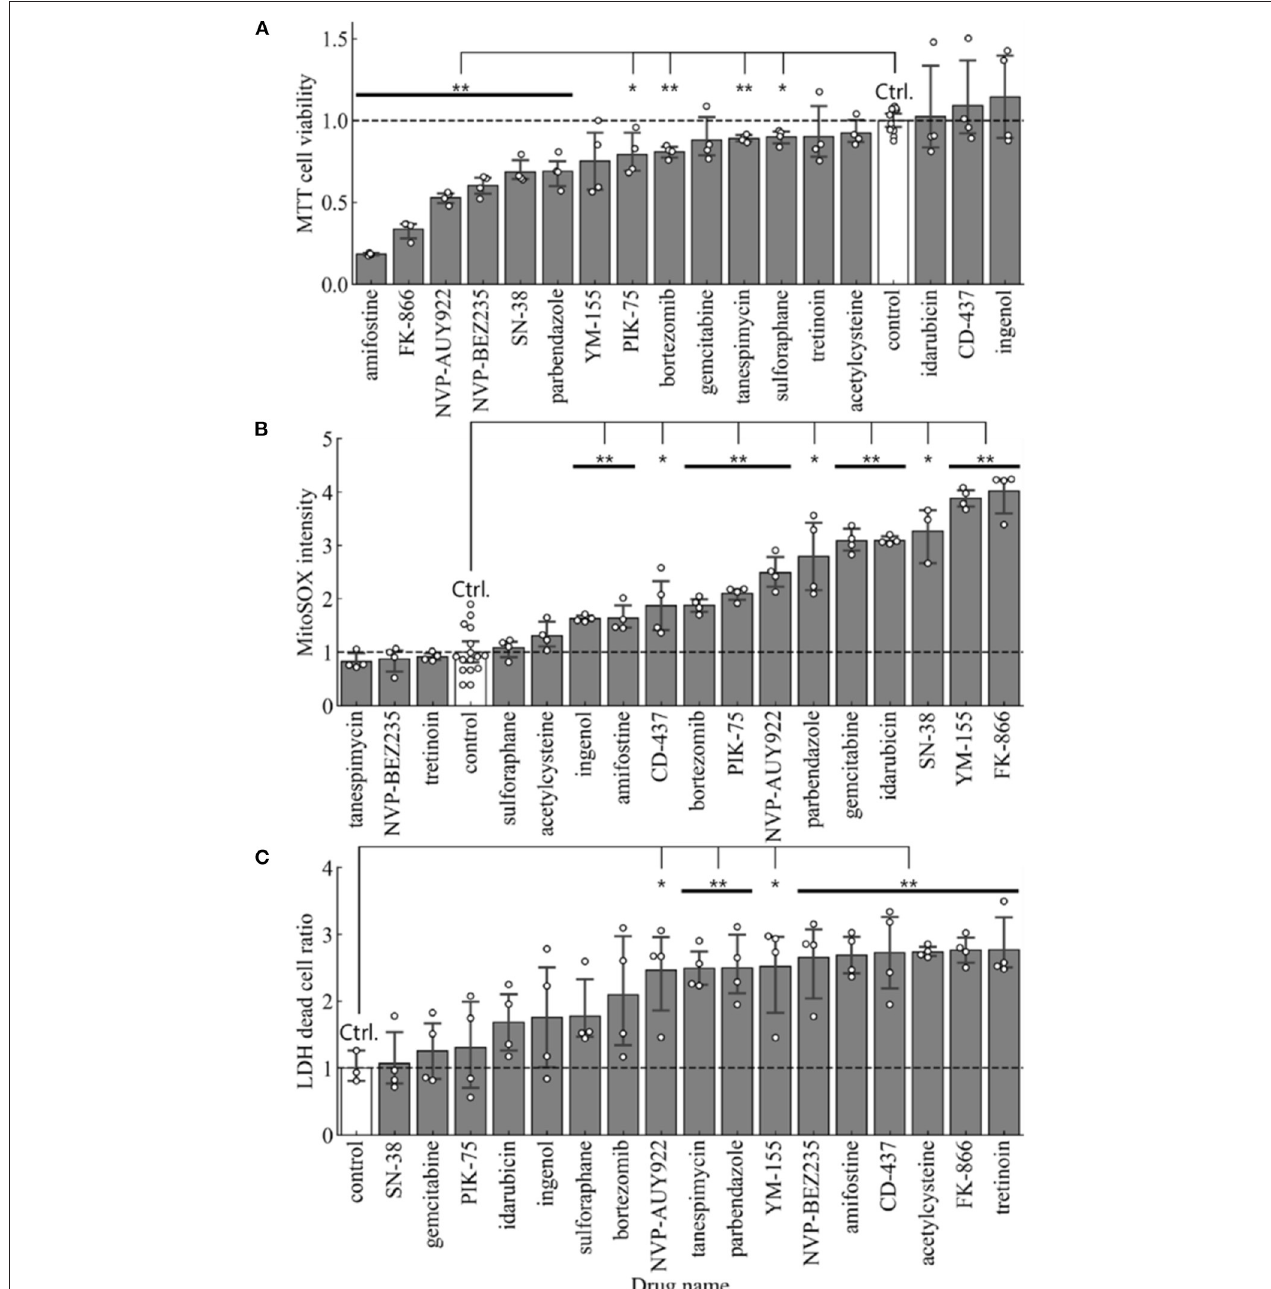
FIGURE 3 | Cell toxicity assay in BEAS-2B treated with each of 17 small molecules and the control. (A) Cell viability measured by MTT assay ( n = 4 in samples and n = 12 in control), (B) Mitochondrial Super Oxide production measured by MitoSOX assay ( n = 4 in samples and n = 16 in control), and (C) Cytotoxicity measured by LDH assay ( n = 4). Error bars mean 95% confidence interval. * p < 0.05, ** p < 0.01.